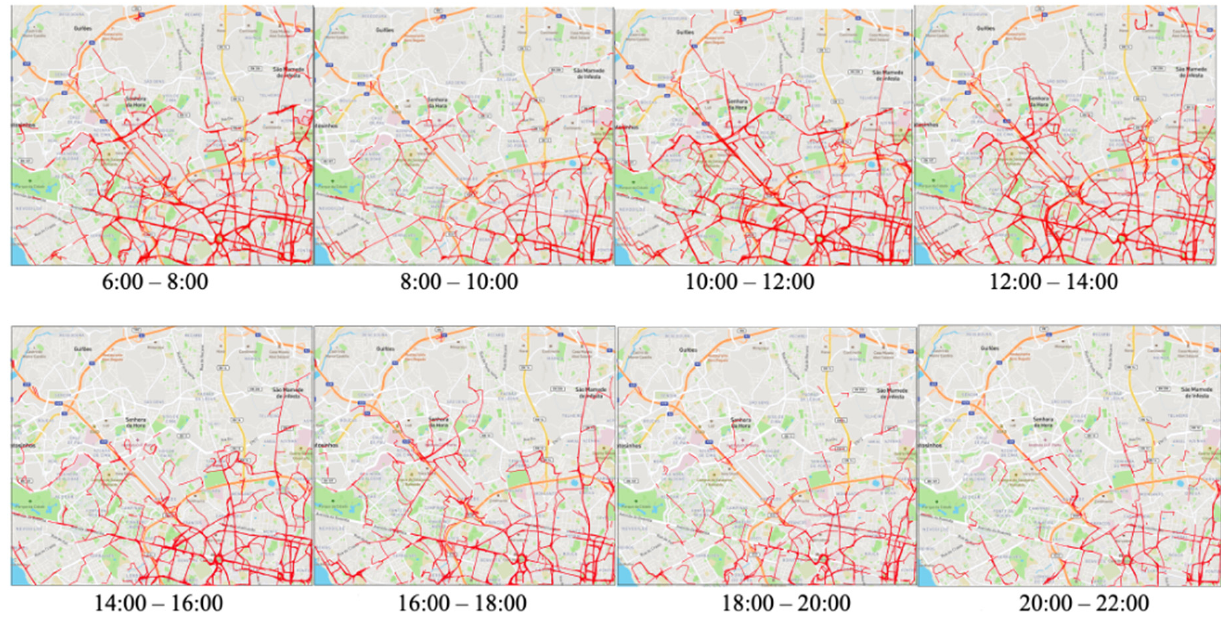
Figure 19. Slow segment evolution of a cell through different spatiotemporal scenarios on Tuesday 6 August 2013, 60